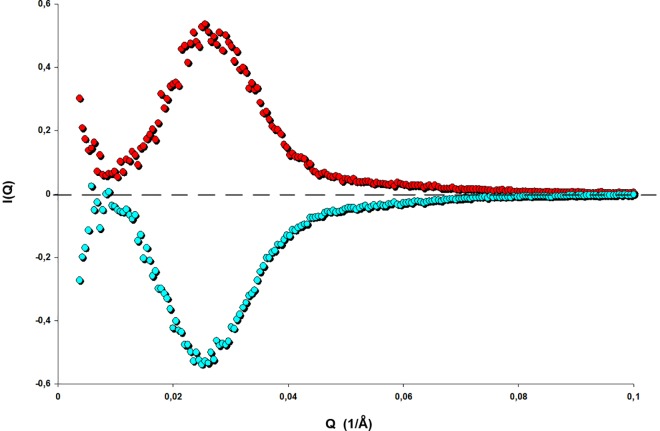
Complementary paths view in conjunction with Fig 3.Upper curve (red): Subtraction of the scattering curve at point P from the path ABPC at p/po = 0.571 from the scattering curve at point A at p/po = 0.468 of the same path. Lower curve (cyan): Subtraction of the scattering curve at point P from the loop DZFPGD at p/po = 0.571 from the scattering curve at point D at p/po = 0.665 of the same path. Note that the two curves are symmetrical except at low-Q values indicating that the paths AP and PD are complementary to each other.